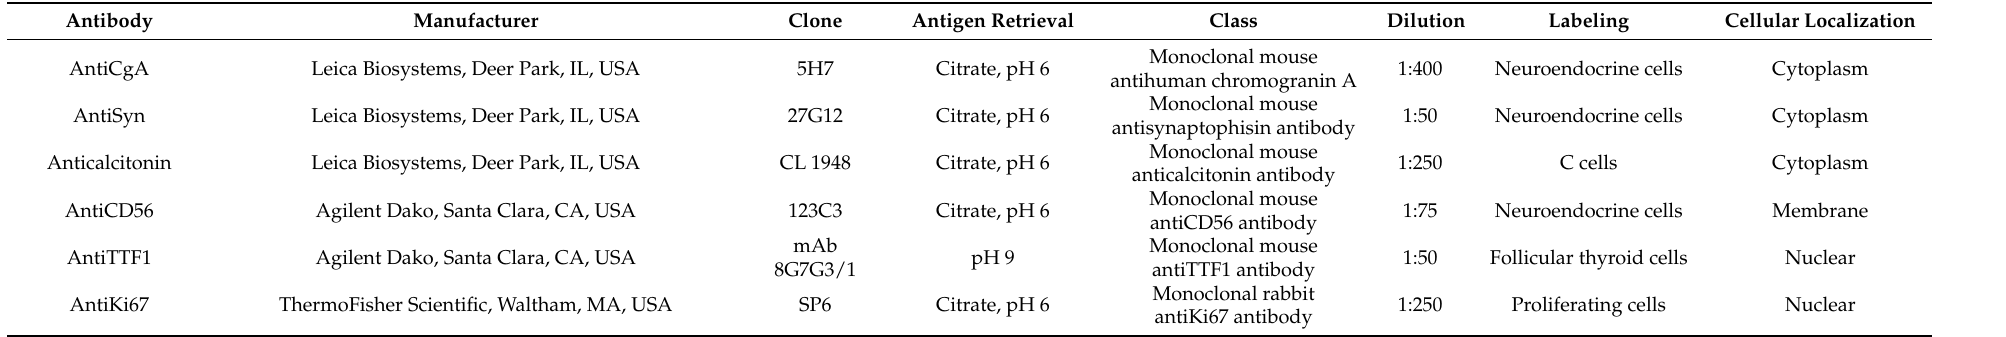
Table 1. The antibodies used for MTC IHC